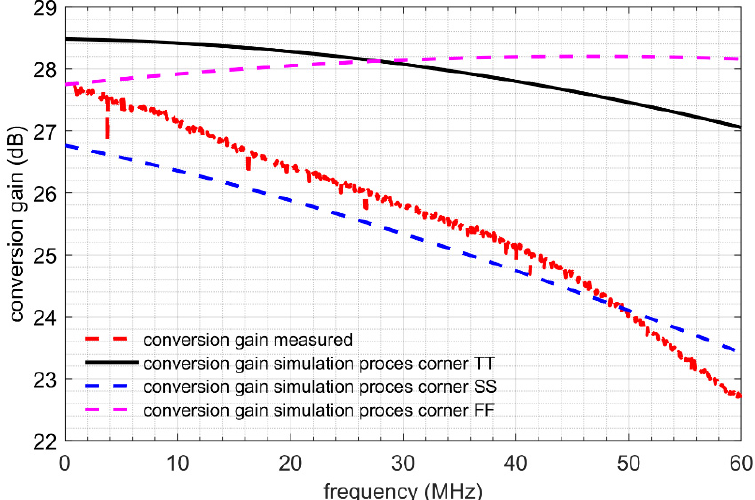
Figure 22. Comparison of measured and simulated voltage conversion gain—balun and mixer.